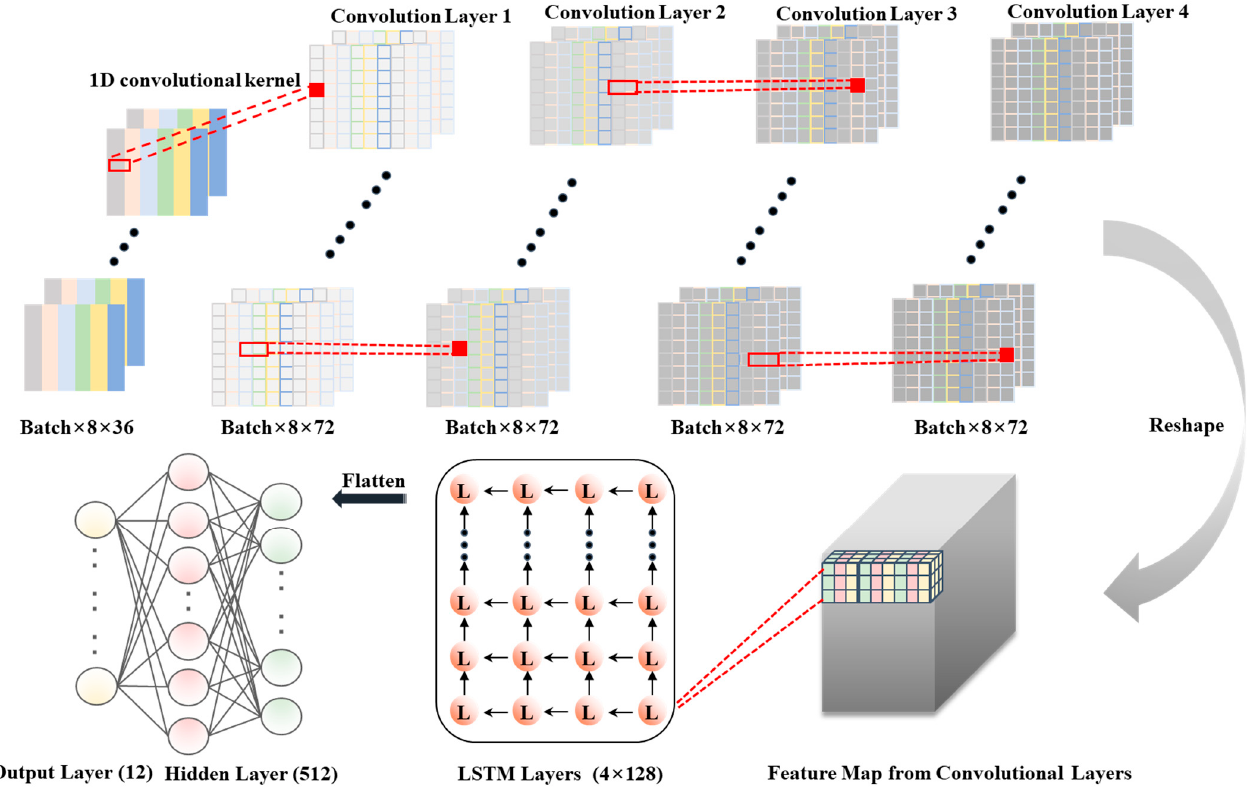
Figure 4. The architecture of the proposed MFAGNet